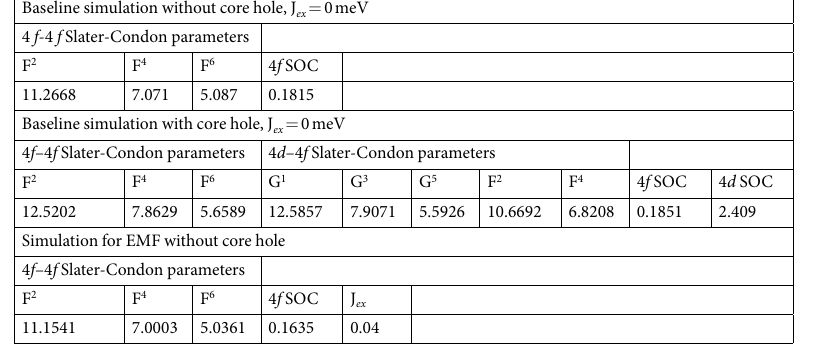
Table 1. Parameters used in atomic multiplet calculations (in units of